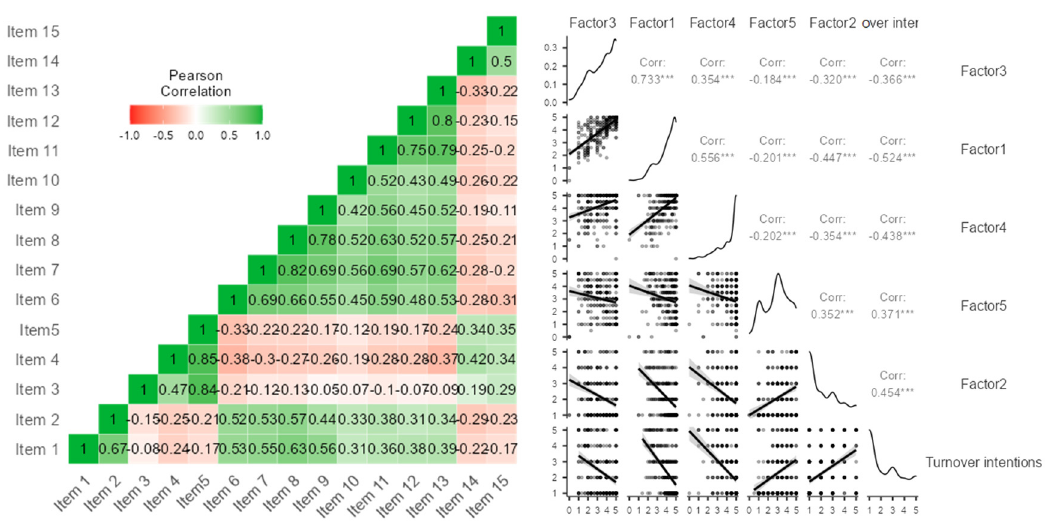
Figure 1. Correlations between the scale items, the 5 factors and turnover intentions. *** significant at p < 0.001. Table 1. Correlations between the scale’s 5 factors and turnover intentions.